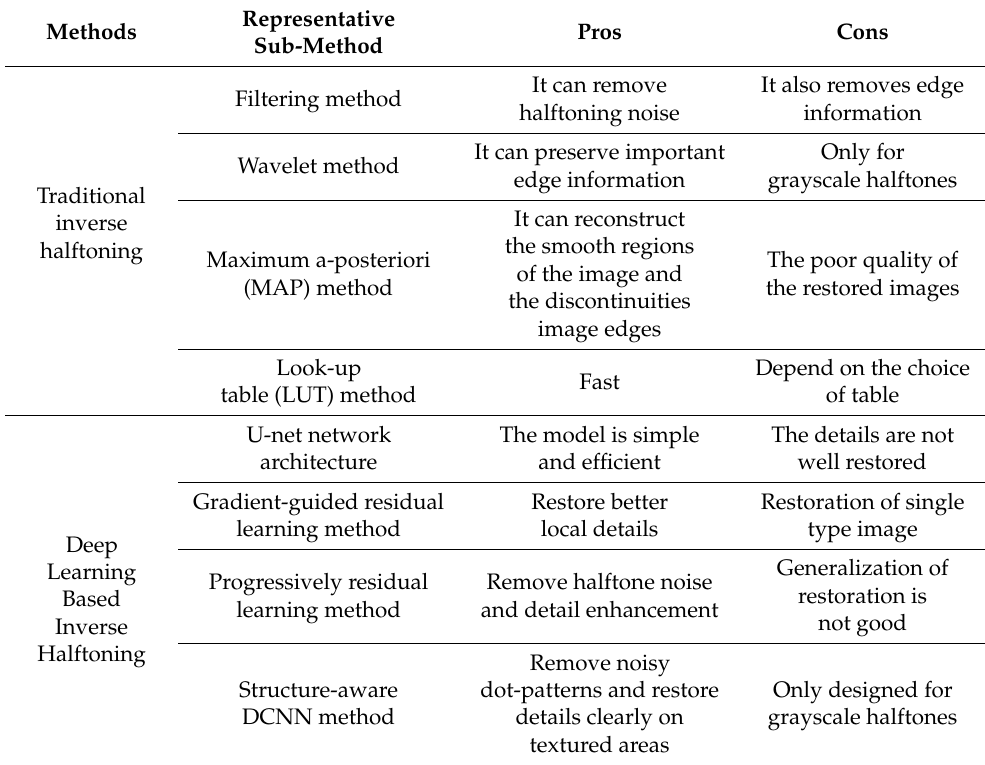
Table 1. A comparative summary of related